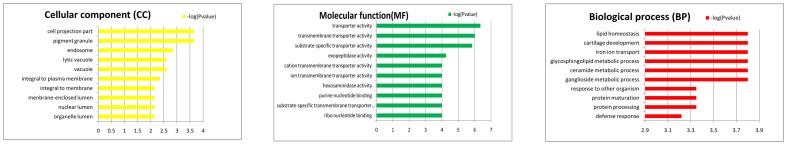
GO annotation of the final selected differentially expressed proteins.These differentially expressed proteins were classified among three categories: cellular component (CC), molecular function (MF) and biological process (BP). According to the GO database, the top 10 components for CC, MF, BP of the selected differentially expressed proteins are shown along with their enrichment score, represented as a p-value.